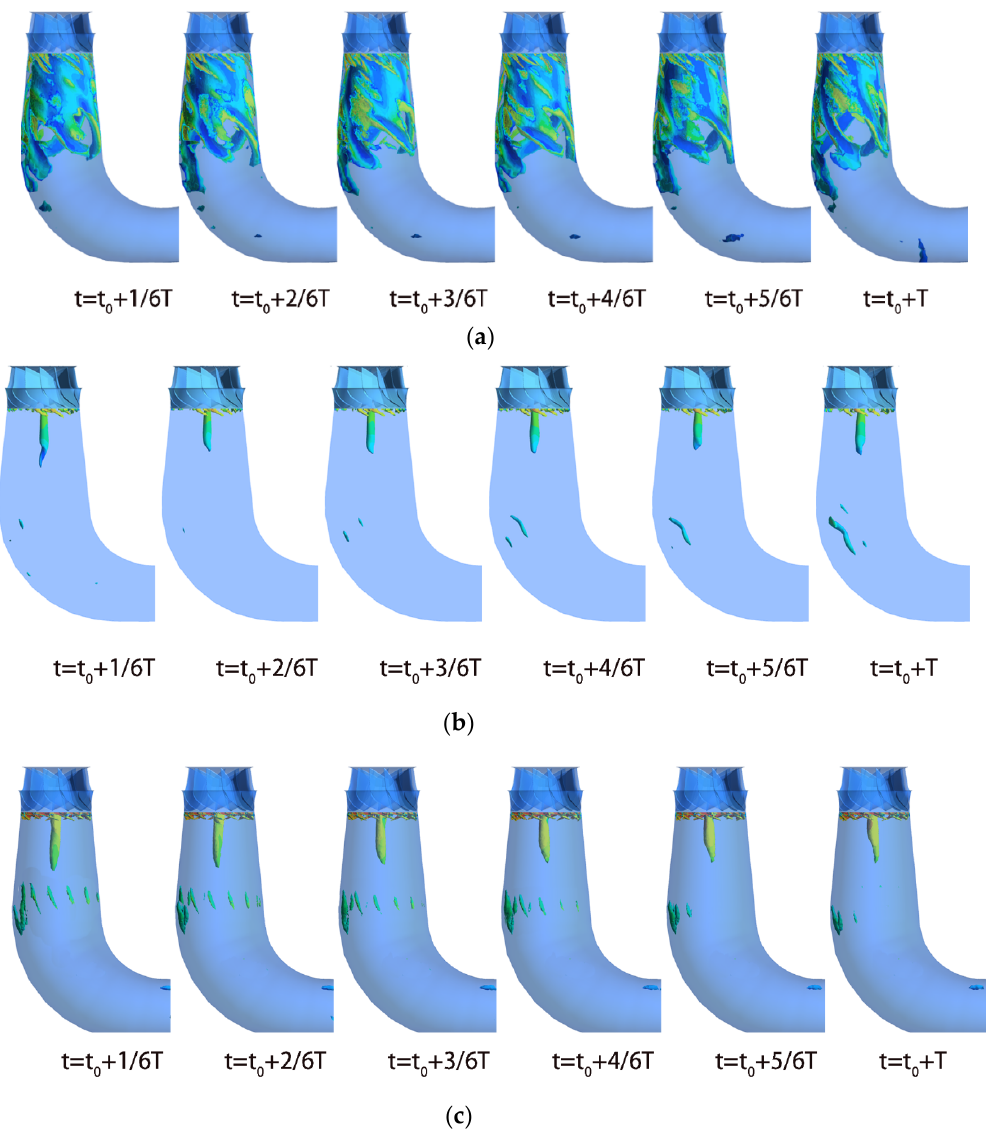
Figure 11. Vortex rope cycle rotation under 91 m head. ( a ) OP1, ( b ) OP2, and ( c ) OP3.